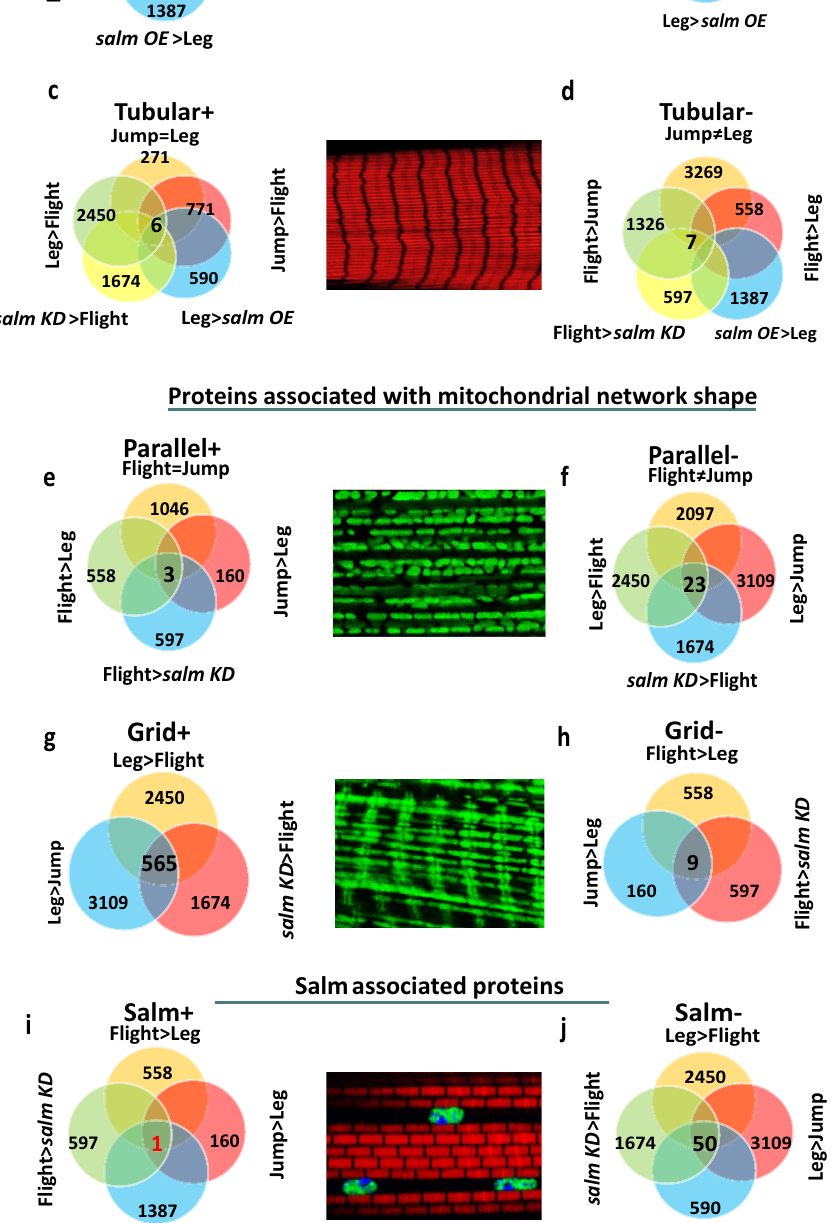
Fig. 3 | Identi fi cation of potential regulatory factors for contractile and mito- chondrial network type in Drosophila muscle. a Venn diagram displaying the individual muscle group comparisons and their overlap for proteins positively associated with fi brillar muscles. b Venn diagram displaying the individual muscle group comparisons and their overlap for proteins negatively associated with fi brillarmuscles. c , d Venndiagramfortubularpositivelyandnegativelyassociated